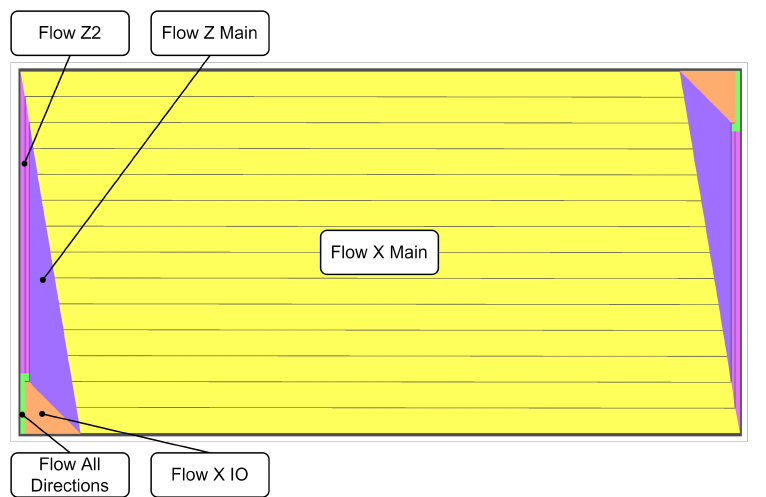
Figure 4. Flow steering sections of homogenized channel mesh. Due to the sophisticated geometry of the flow field, five flow steering sections were created.